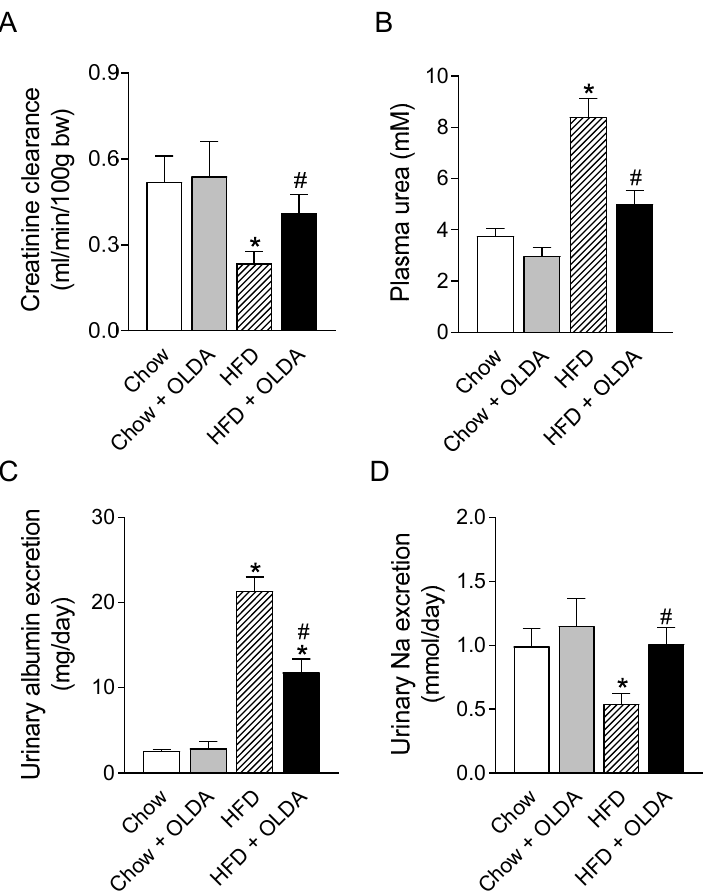
Figure 4. Effects of OLDA on renal function. Creatinine clearance ( A ), plasma urea level ( B ), urinary albumin excretion ( C ), and urinary sodium excretion ( D ) in chow-fed or high-fat-diet (HFD)-fed rats after 8 week of treatment with or without intrathecal N-oleoyldopamine (OLDA) treatment (1 ng/kg, daily). Values are means ± SE (n = 8). * p < 0.05 compared with that of the chow group; # p < 0.05 compared with that of the HFD